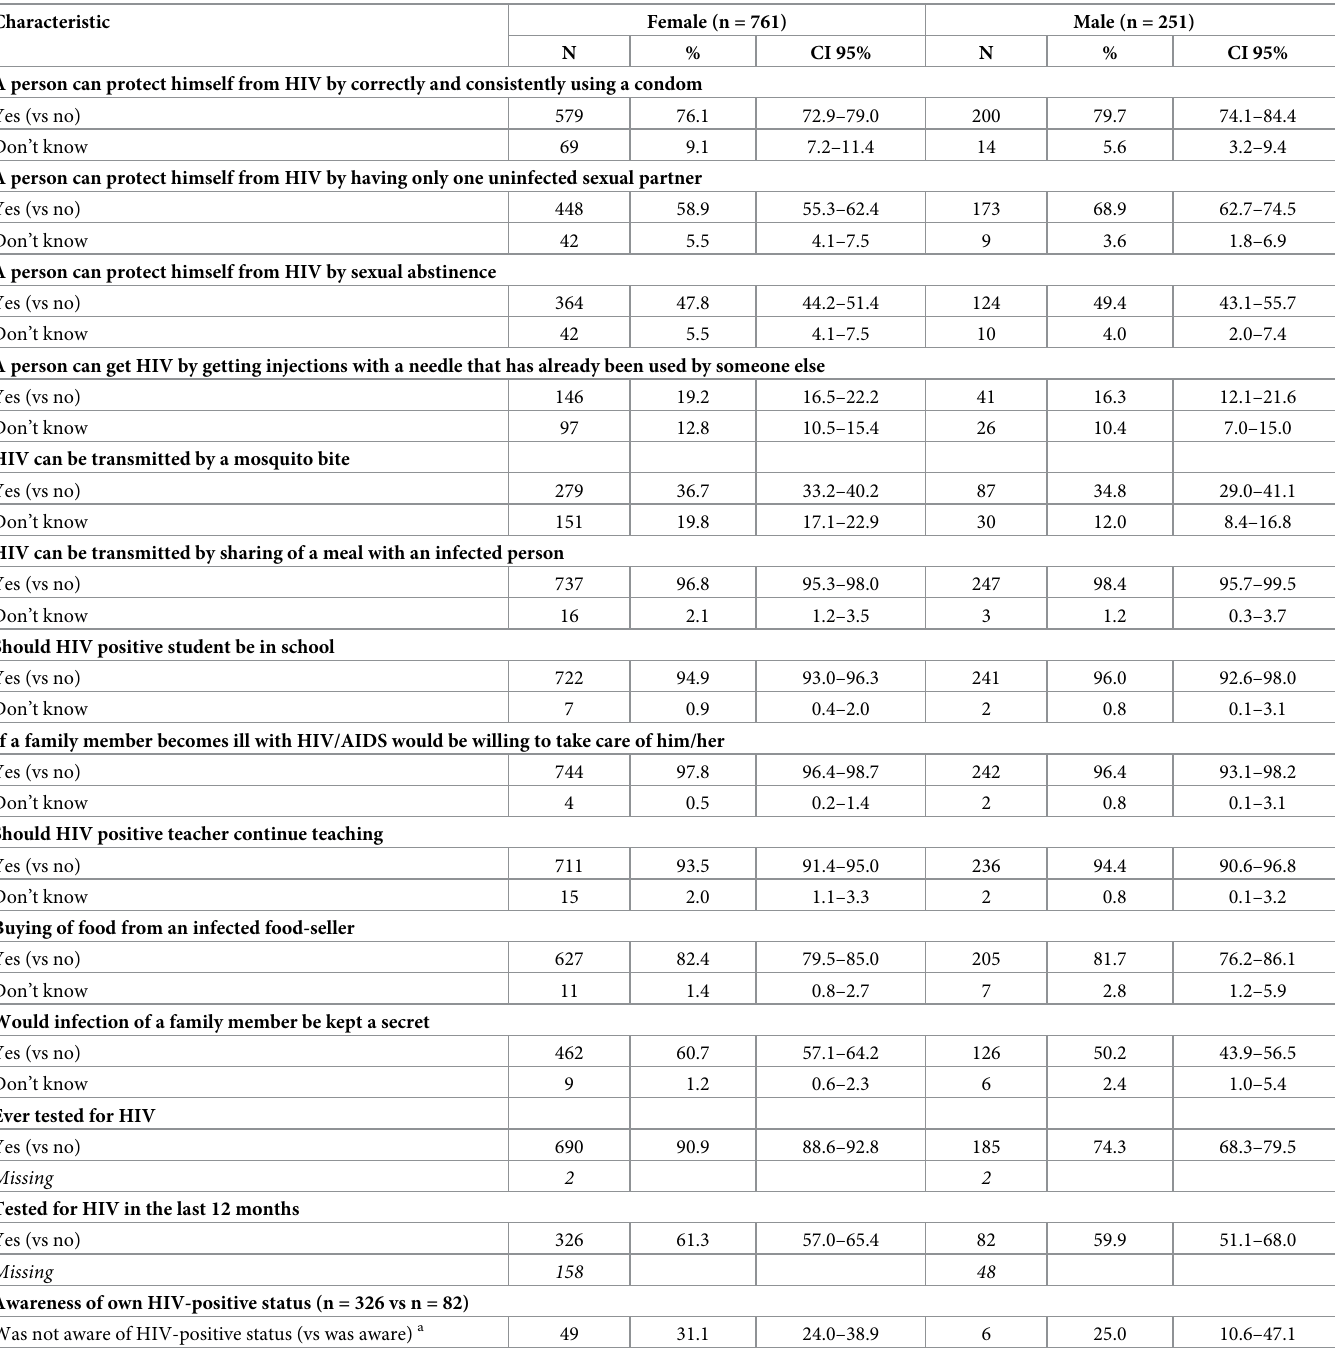
Table 3. Knowledge, attitudes and perceptions about HIV in miners community of origin, Gaza Province, Southern of Mozambique, 2017. Characteristic Female (n =